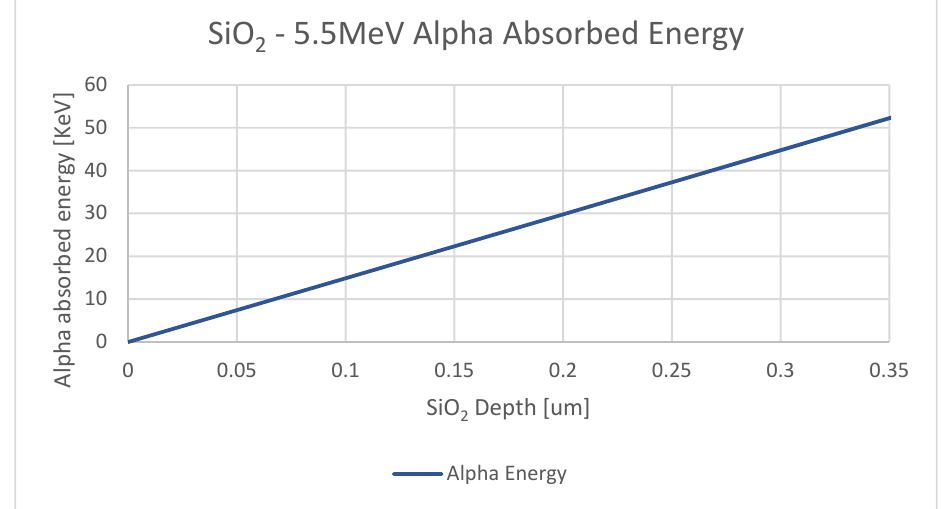
Figure 2. Absorbed energy of a 5.5 MeV alpha particle crossing SiO (cid:2870) layer with range of 3500𝐴(cid:4662) .